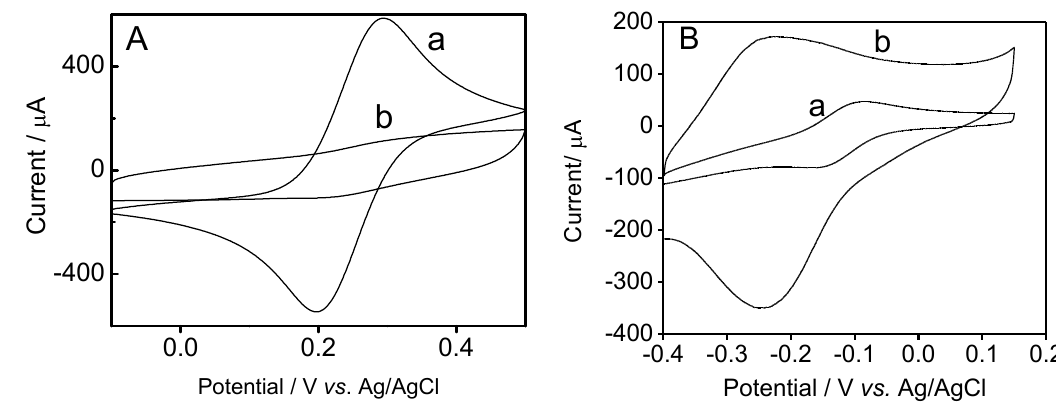
Figure 2. Cyclic voltammograms of bare graphite and graphite electrode modified with poly(4-ATP): ( A ) in aqueous solution containing K and KCl (0.10 mol·L − 1 ); ( B ) in aqueous solution containing Ru(NH and KCl (0.10 mol·L − 1 ). Bare graphite electrode (a) and modified graphite electrode with 4-ATP (b) Scan rate: 50 mV·s − 1